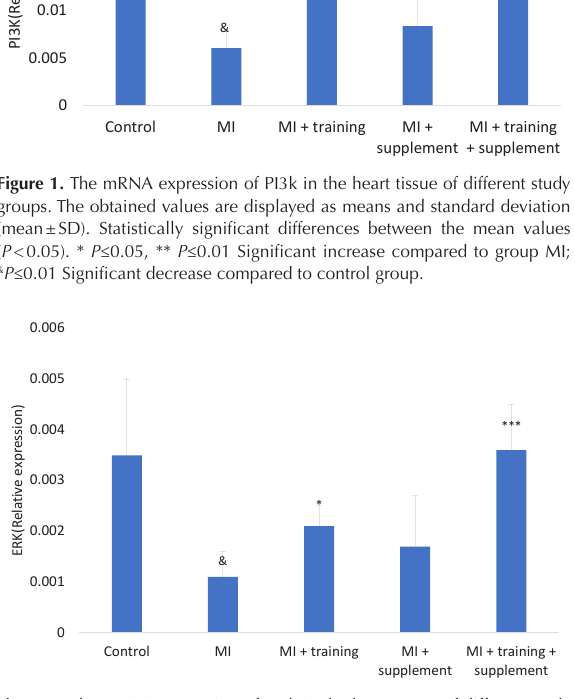
Figure 2. The mRNA expression of PI3k in the heart tissue of different study groups. The obtained values are displayed as means and standard deviation (mean ± SD). Statistically significant differences between the mean values ( P < 0.05). * P ≤0.05, ** P ≤0.01 Significant increase compared to group MI; & P ≤0.01 Significant decrease compared to control